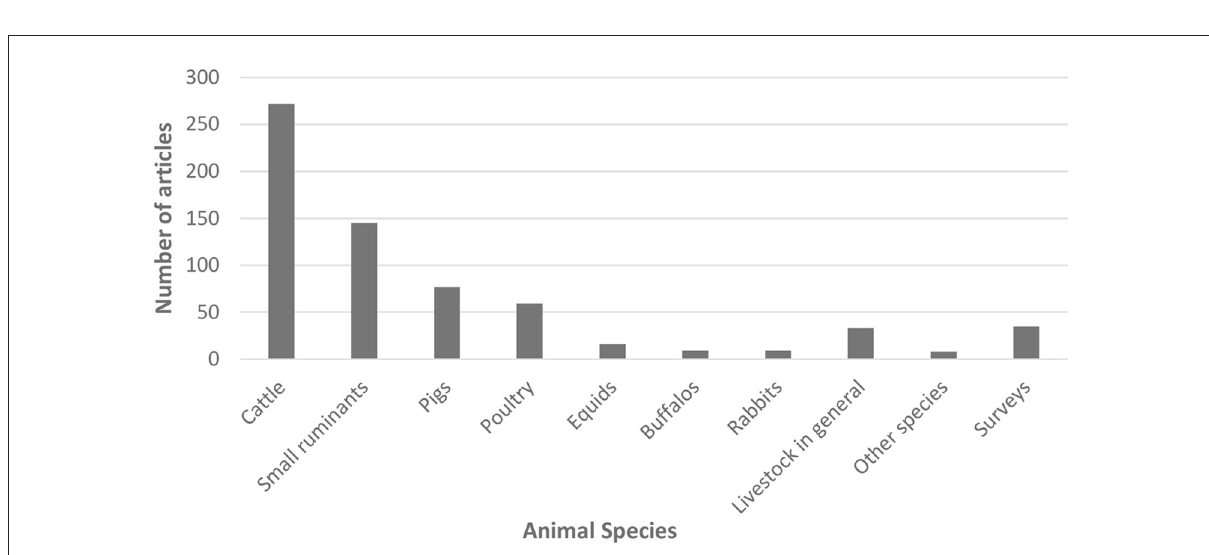
FIGURE3 Animal species considered in the publications on farm animal welfare in Latin American countries between 1992 and 2021 ( n = 663).